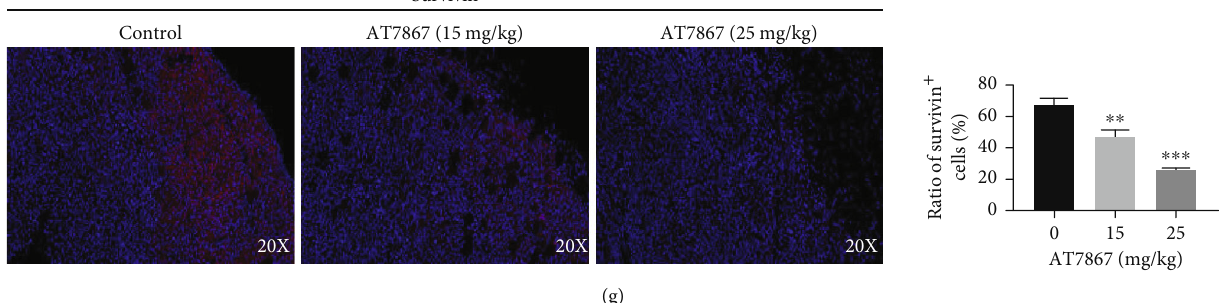
Figure 8: Anticancer e ffi cacy of AT7867 on CSCs derived from CRCs xenografts. (a) Tumors derived from HCT116 CSC-bearing nude mice after 14 days of AT7867 treatment. (b) The growth curves of tumor volume of CSC-bearing mice. (c) Scatter diagrams of tumor weight of H446 CSC-bearing mice. (d, e) Ki67 and TUNEL staining on tumor sections from CSC-bearing mice treated with control, 15mg/kg, or 25 mg/kg AT7867. (f, g) Immuno fl uorescent staining of Ascl2 or Survivin on tumor sections from CSC-bearing mice. ∗ P <